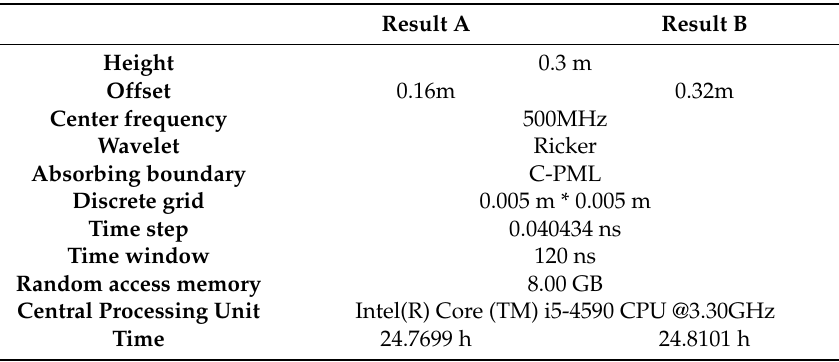
Figure 6. ( a ) The synthetical regolith model, ( b ) Forward result A with offset of 0.16 m ( c ) Forward result B with offset of 0.32 m. Table 2. Simulation Parameter.